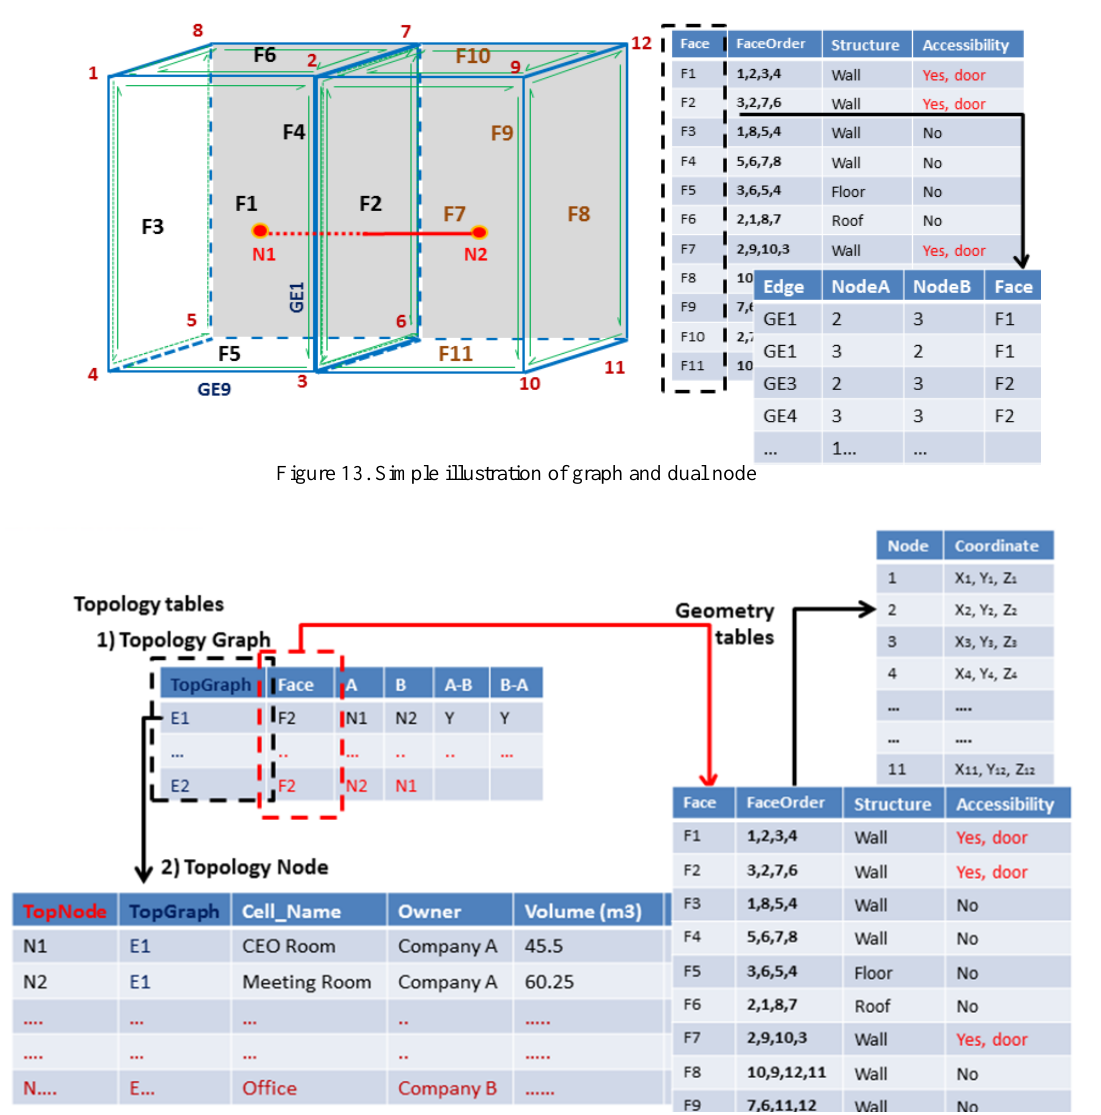
Figure 14. Relationship of geometry, graph (topology) and attribute